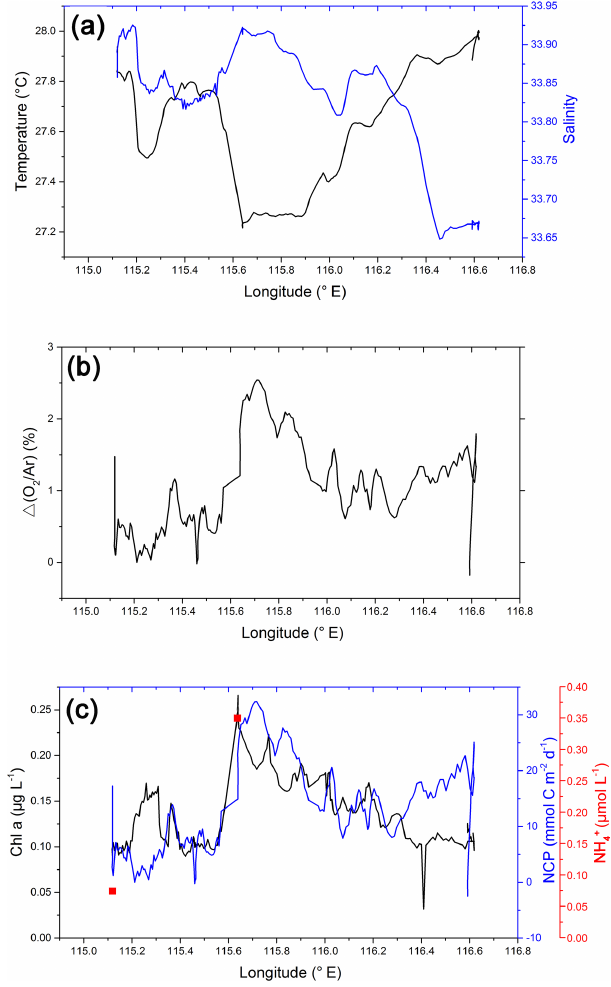
Figure 5. Zonal variations in (a) temperature, salinity, (b) (cid:49) (O 2 / Ar), (c) Chl a , NCP, and the surface concentration of ammonia (NH + ) along Transect 5 in October 2014. The plots of 4 (cid:49) (O 2 / Ar) and NCP are 10-point Savitzky–Golay smoothed to give a better view of their